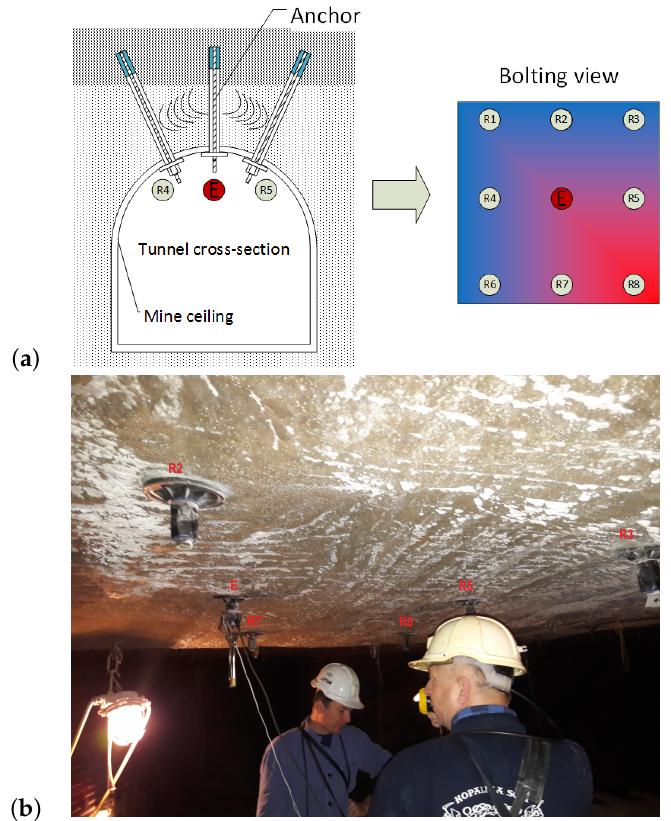
Figure 2. Schematic of a system with multiple receivers on multiple anchors: ( a ) Diagram, ( b ) Real mine view with labelled